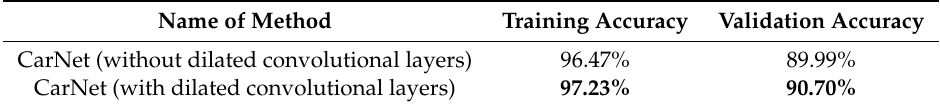
Table 3. Comparison of training and validation accuracies for CarNet (with dilated convolutional layers) verses CarNet (without dilated convolutional